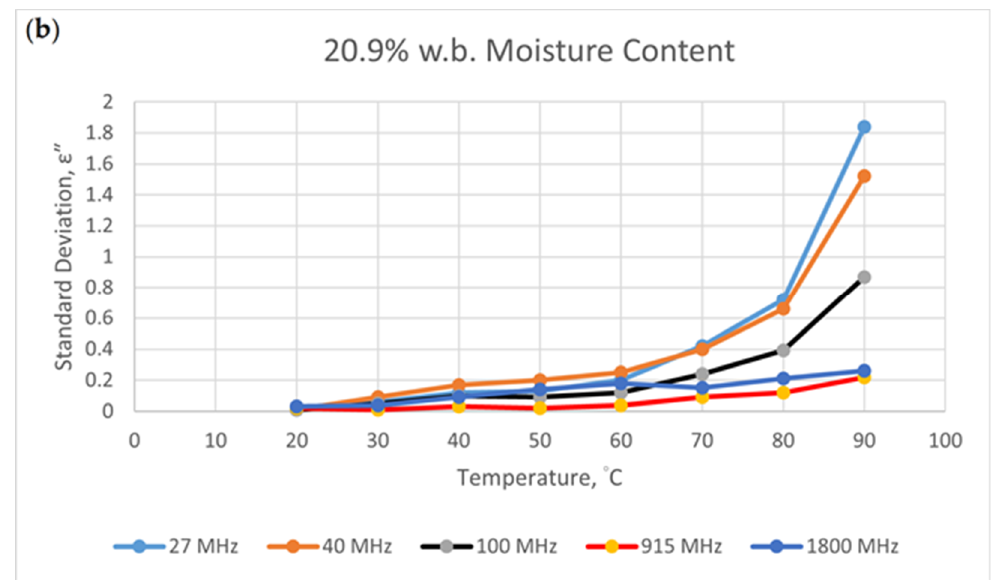
Figure 6. The relationship between the standard deviation of the measured data and the temperature at different frequencies for two moisture contents; ( a ). 11.4% w.b. moisture content; ( b ). 11.4% w.b. moisture content.